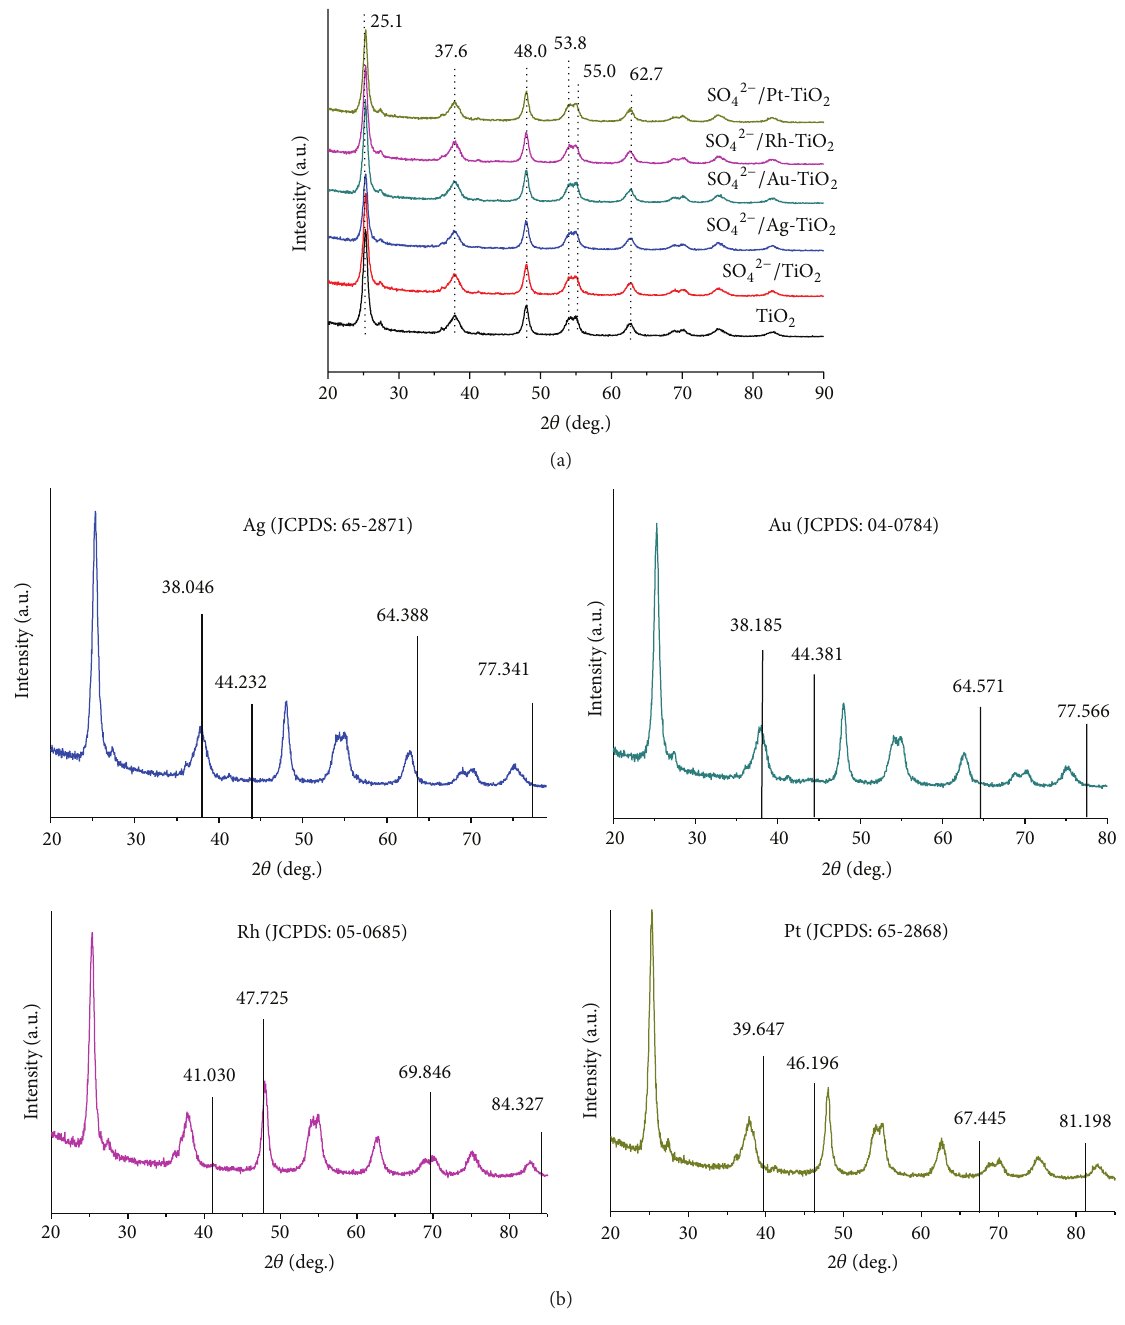
Figure 1: (a) XRD patterns of the samples (b) JCPDS of SO 42− /M-TiO 2 (M = Ag, Au, Rh, and Pt) samples.